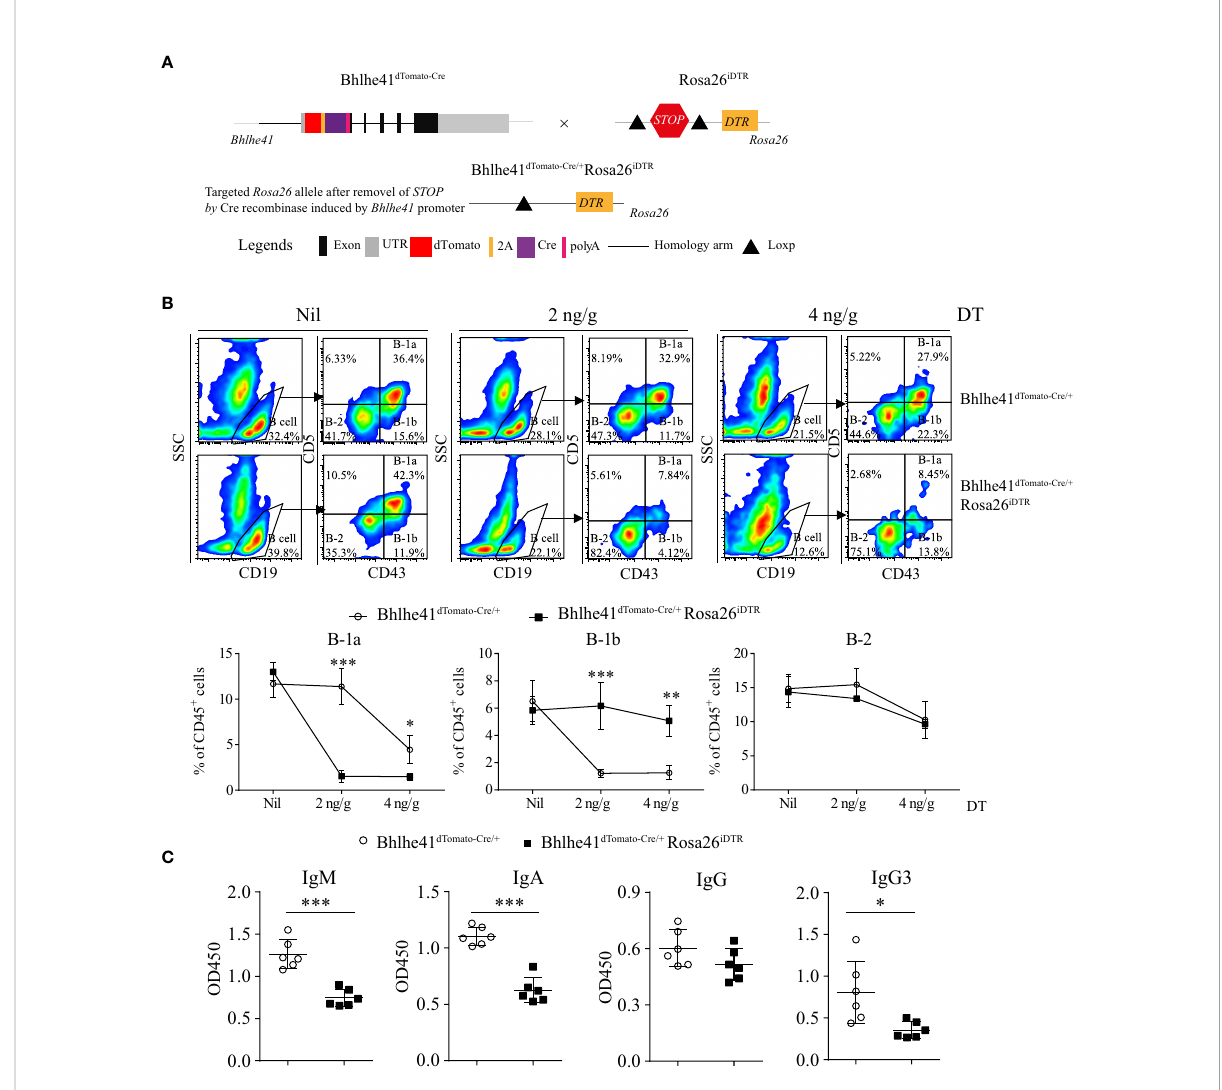
FIGURE 5 Ef fi cient depletion of B-1 cells using Bhlhe41 dTomato-Cre/+ Rosa26 iDTR mice. (A) Generation of Bhlhe41 dTomato-Cre/ + Rosa26 iDTR mice for deletion of B-1 cells. (B) Adult Bhlhe41 dTomato-Cre/ + Rosa26 iDTR mice were injected with a single dose of diphtheria toxin (DT) (2 and 4 ng/g) and sacri fi ced 48 h after DT injection. Immune cells were analyzed by fl ow cytometric analysis. Two-way ANOVA, followed by Bonferroni multiple comparison test, was used for the statistical analysis. (C) Adult Bhlhe41 dTomato-Cre/ + Rosa26 iDTR mice were injected with two doses of DT (2 ng/g) every 3 days and immunized with NP-Ficoll 1 day after the fi rst injection of DT. Serum NP-speci fi c antibodies were analyzed by ELISA. Differences between two groups for each Ig subtype were analyzed by Student ’ s t-test. * P < 0.05, ** P < 0.01, *** P <